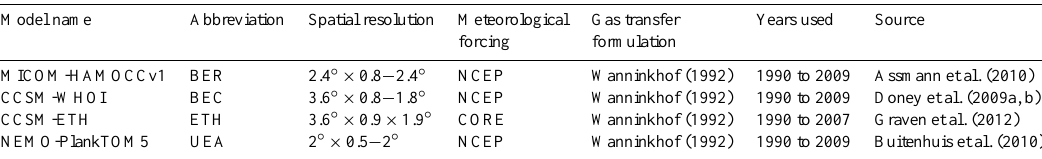
Table 2. Characteristics of the four ocean biogeochemical general circulation models (OBGCMs). All include NPZD-type ecosystem models and N, P, Si, and Fe nutrient